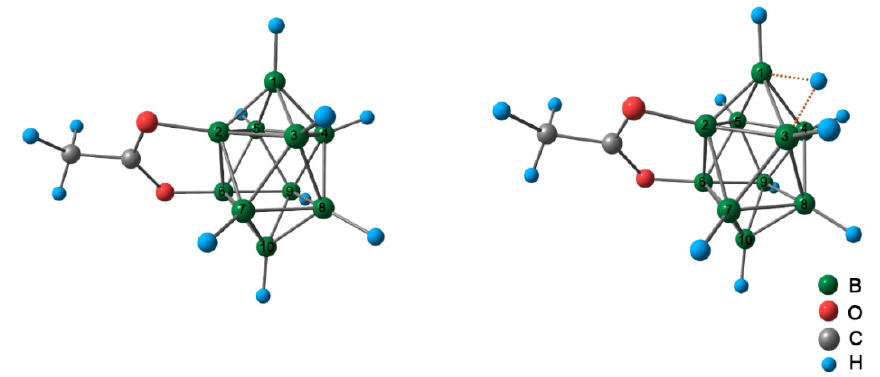
− and [2,6-B fac ] 0 . 10 H 8 O 2 CCH 3 *H